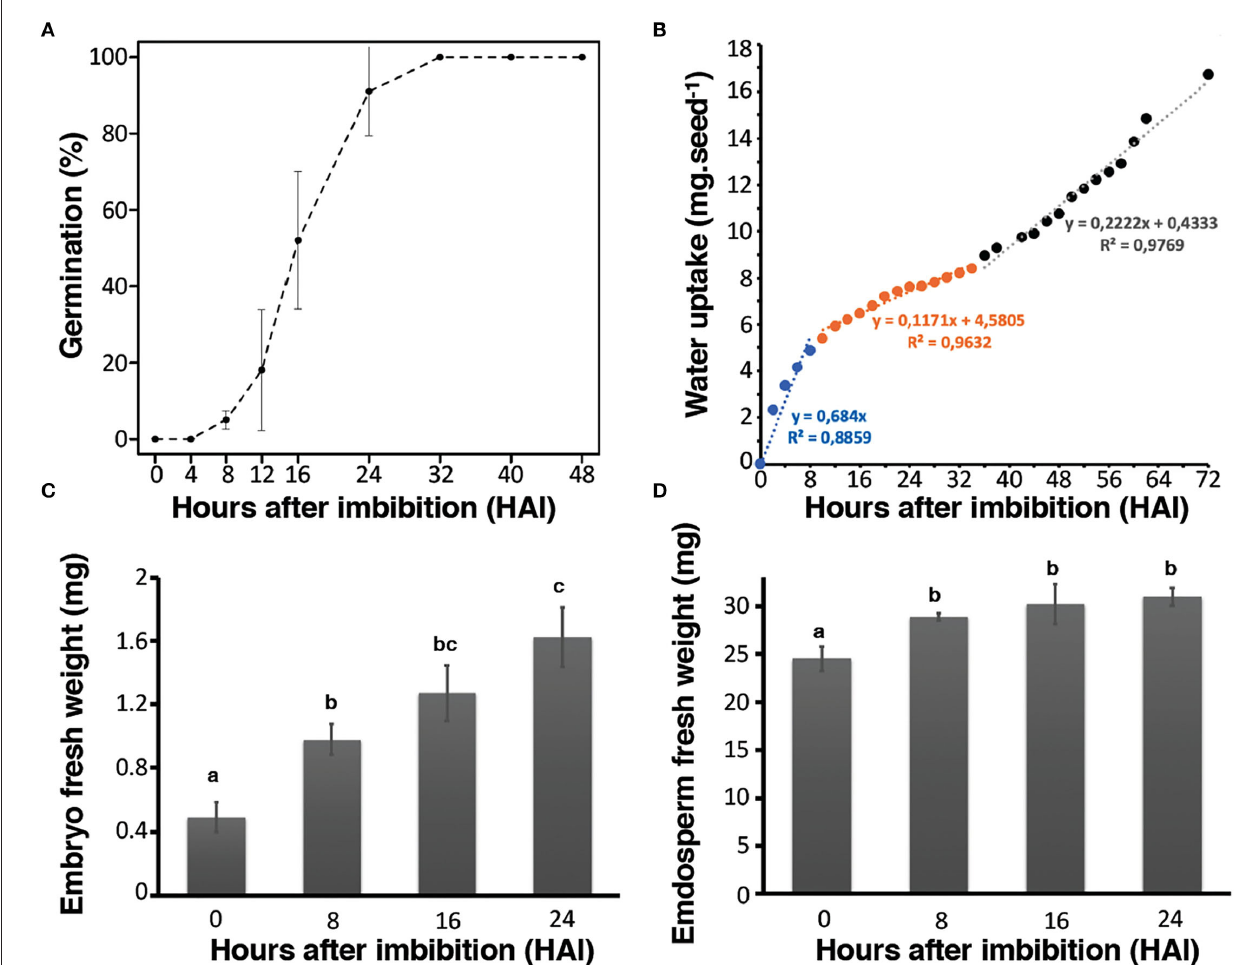
FIGURE 1 | Germination kinetics of Nipponbare rice seeds. Germination assays were carried out at 30 ◦ C under dark and continuous oxygenation conditions in triplicate. (A) Germination rate of seeds up to 48h post-imbibition. (B) Water uptake in mg of whole rice seeds from 0 to 72h post-imbibition. The fitted linear models of fresh weight uptake as a function of time are indicated on the graph to highlight the phase I (blue), phase II (orange), and phase III (black) of rice germination. (C) Water uptake of isolated embryos; (D) water uptake of isolated endosperms. Values are presented as the means ± SD of three replicates. Different letters in (C) and (D) indicate significant differences ( p < 0.05, Tukey–Kramer